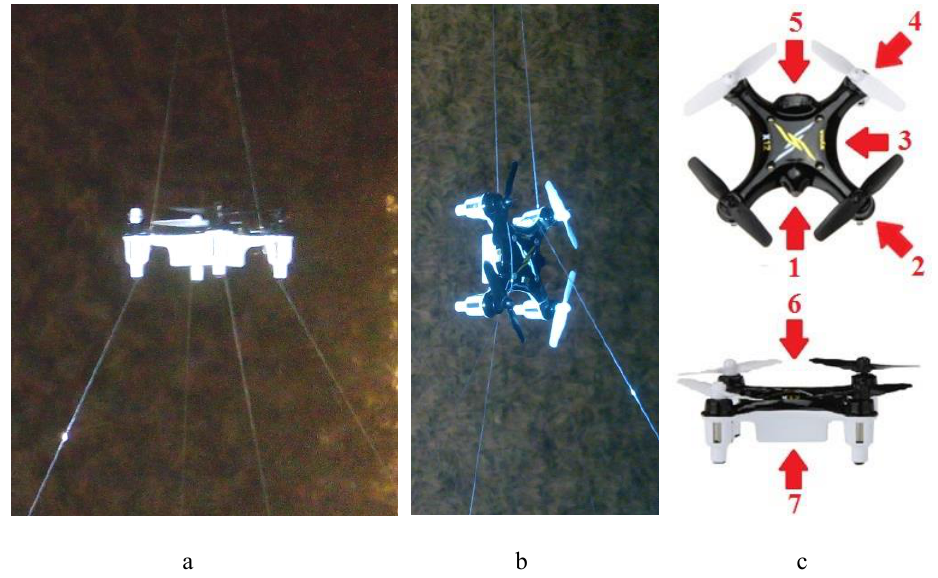
Fig. 3. The quadrocopter Syma X12 placed in the backscattering characteristics measuring bench for small and ultrasmall objects RCS in K a -band : a – horizontal state, b – vertacal state, c – main radiation